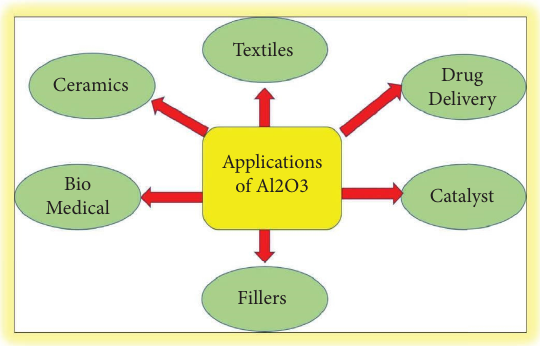
Figure 1: Applications of Al